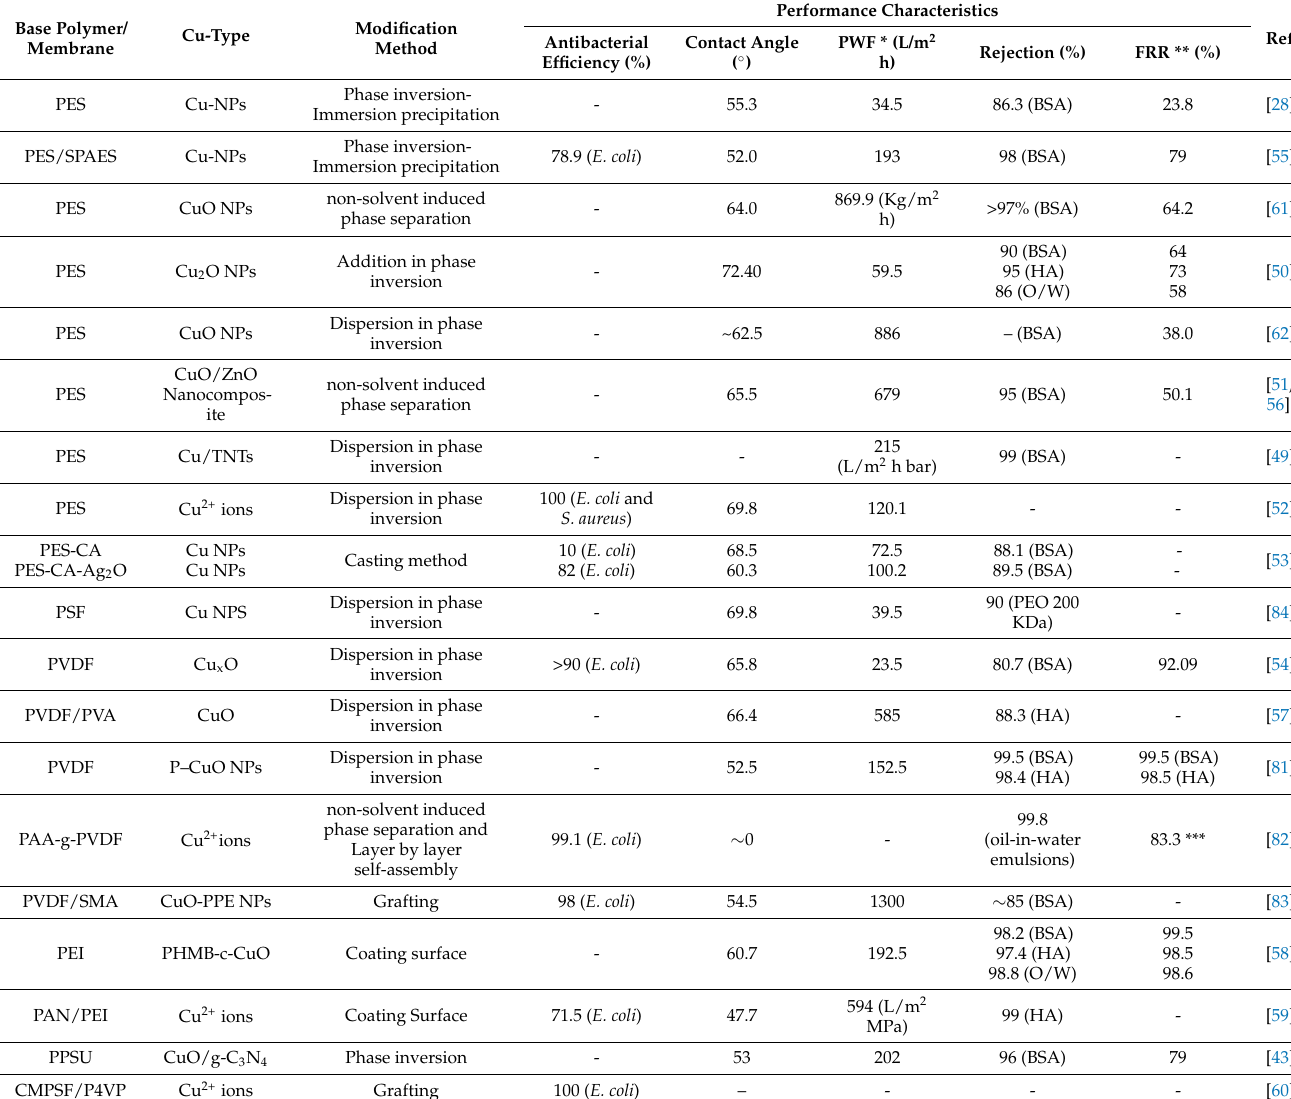
Table 5. A comparative summary of the UF membranes modified with